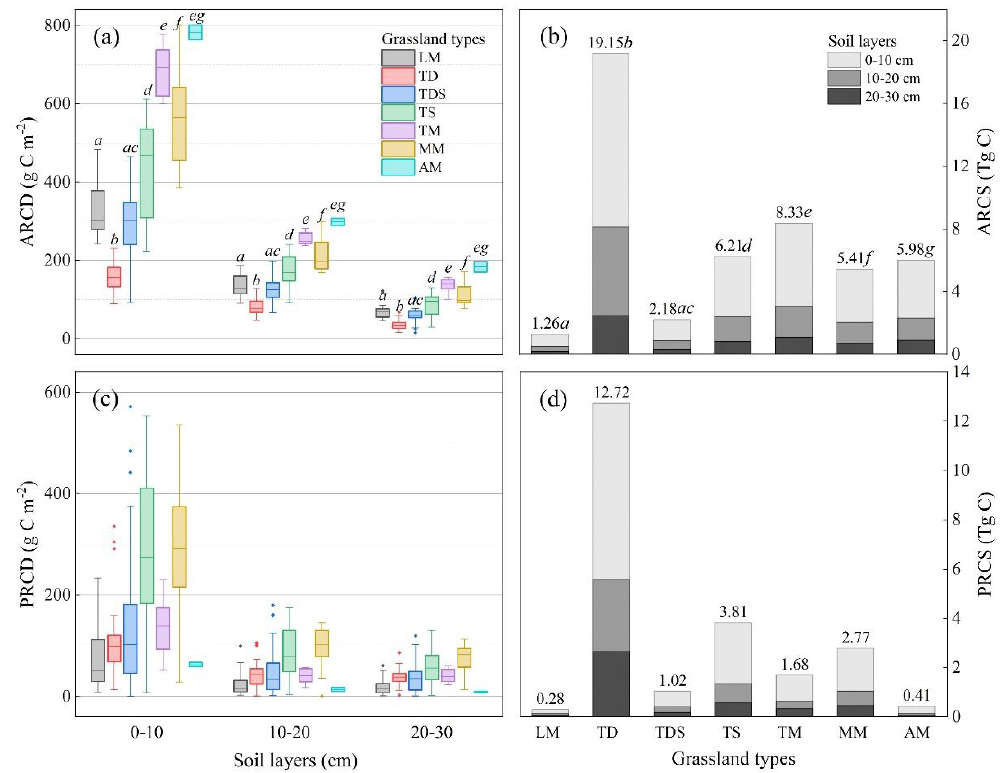
Figure 3. Statistical characteristics of root carbon in different grassland types in Altay Prefecture.